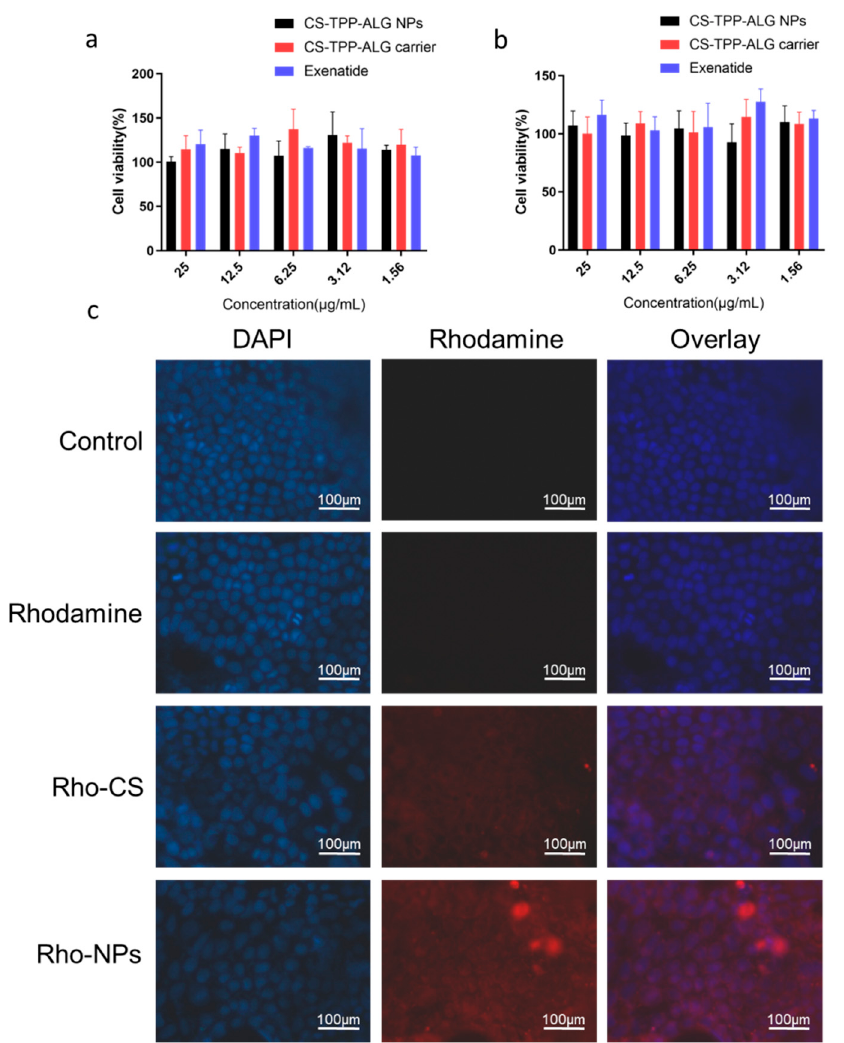
Figure 3. ( a , b ) The cytotoxicity of CS-TPP-ALG NPs, CS-TPP-ALG carrier, and exenatide in Caco-2 cells after 24 h ( a ) and 72 h ( b ). ( c ) Intracellular distribution of Rho-CS-TPP-ALG NPs in Caco-2 cells. Cells were exposed to Rhodamine B, Rho-CS, and Rho-CS-TPP-ALG NPs at 37 °C for 4 h, the concentration of fluorescence was 1